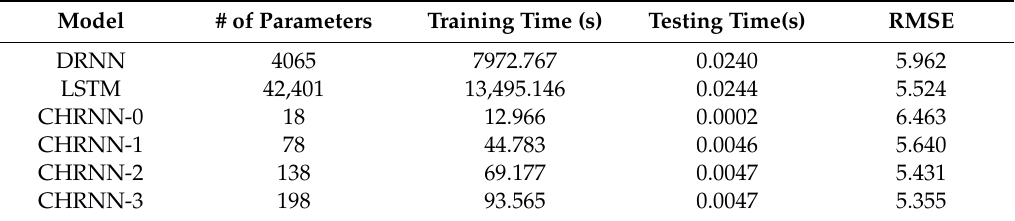
Table 6. Prediction results for FengYuan between the deep recurrent neural network (DRNN), long